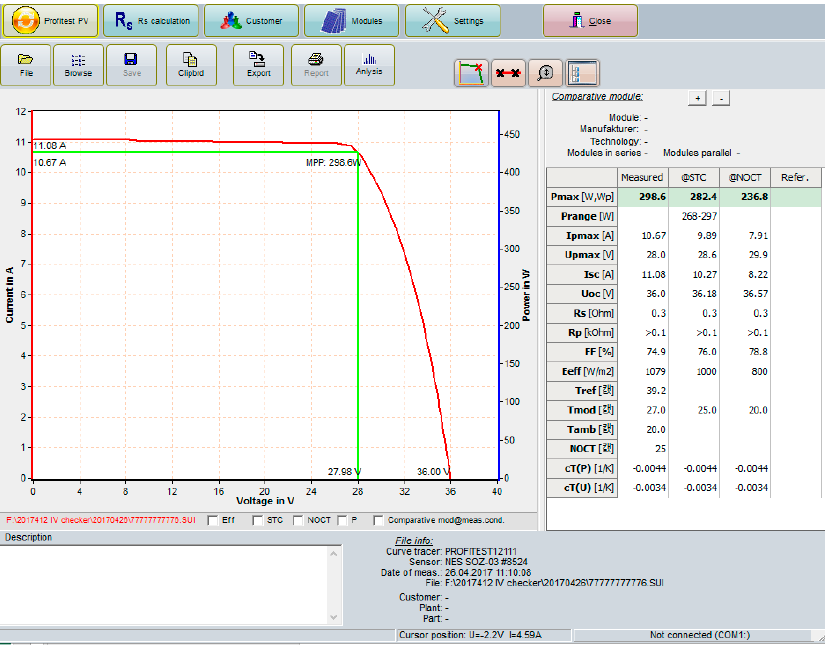
Figure 10. I–V test results.